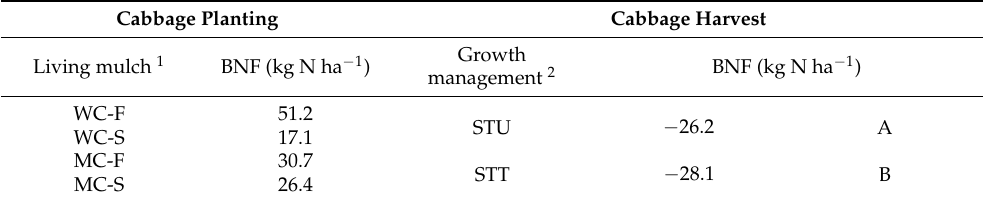
Table 5. Estimated biological N 2 fixation (BNF) before cabbage planting (both locations) and harvest- ing (UH). Values with at least one identical letter indicate non-significant differences among growth management treatments at α = 0.05. Values without letters were not found to be significantly different indicated via global F test.